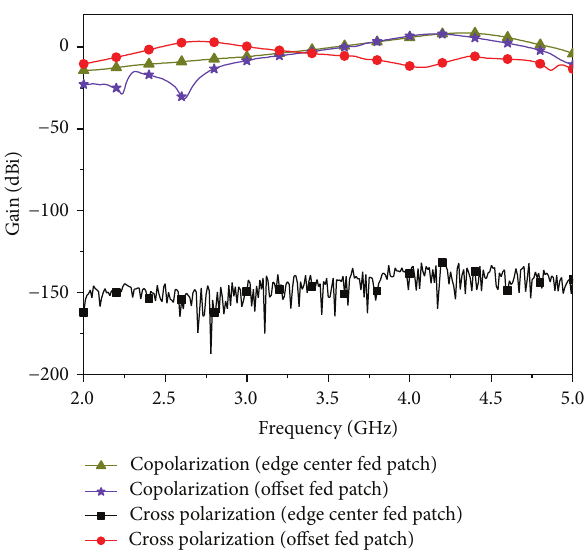
Figure 4: Gains in the main beam direction calculated by copolar and cross-polar components of the offset fed and edge center fed antennas as a function of frequency.